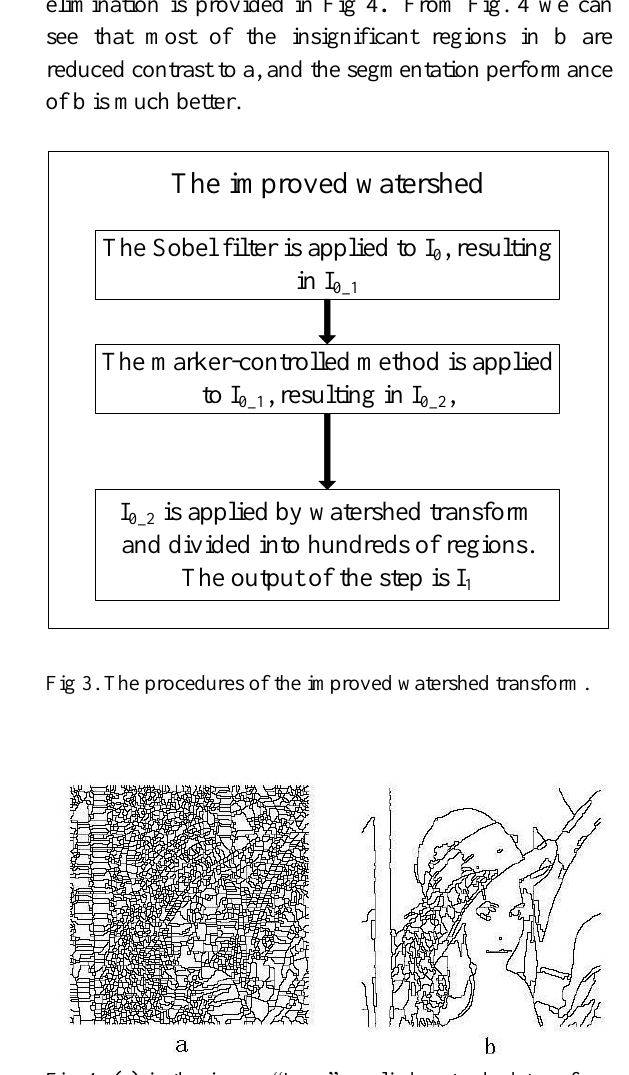
Fig 4. (a) is the image “Lena” applied watershed transform immediately, (b) is “Lena” applied improved watershed